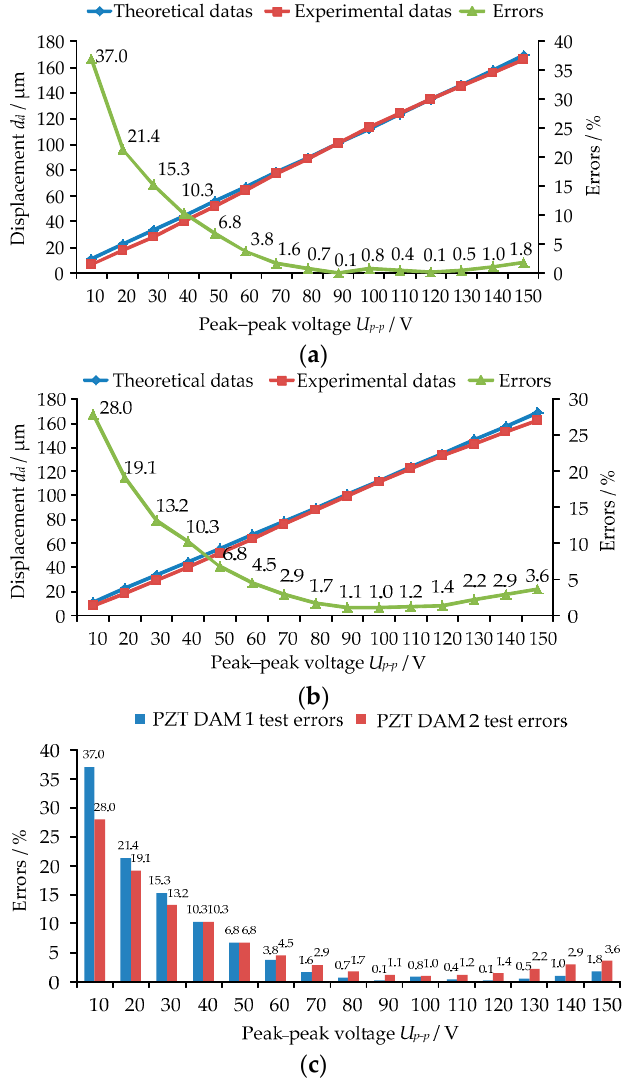
Figure 8. Experimental results of output displacement of piezoelectric displacement amplification mechanism. ( a ) Displacement amplification mechanism 1 test results; ( b ) Displacement amplification mechanism 2 test results; ( c ) The error between the experimental result and the theoretical calculation.